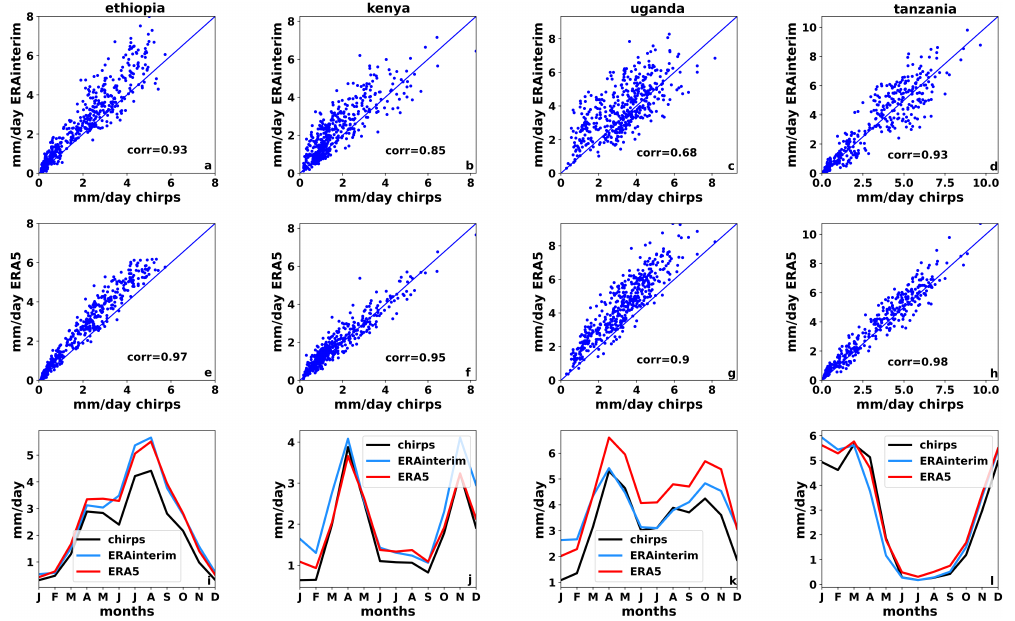
Figure 14. Monthly mean precipitation from 1981 to 2017 in observations (CHIRPS) versus ERA-interim ( a – d ) and ERA5 ( e – h ) in the four focus countries (columns). Annual cycle of monthly mean precipitation ( i – l ) averaged over the corresponding country as observed (black line), in ERA- interim (blue line) and ERA5 (red